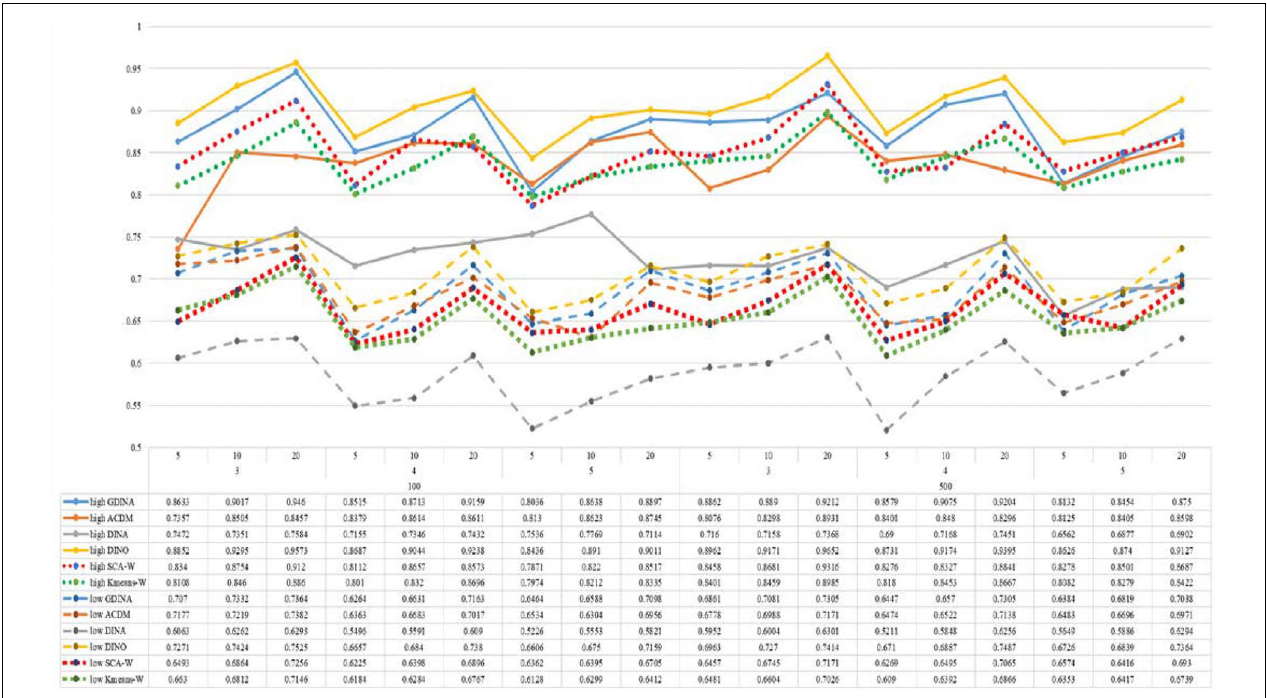
FIGURE 8 | Mean values of ω by SCA, K-means, and fitted models; True model =